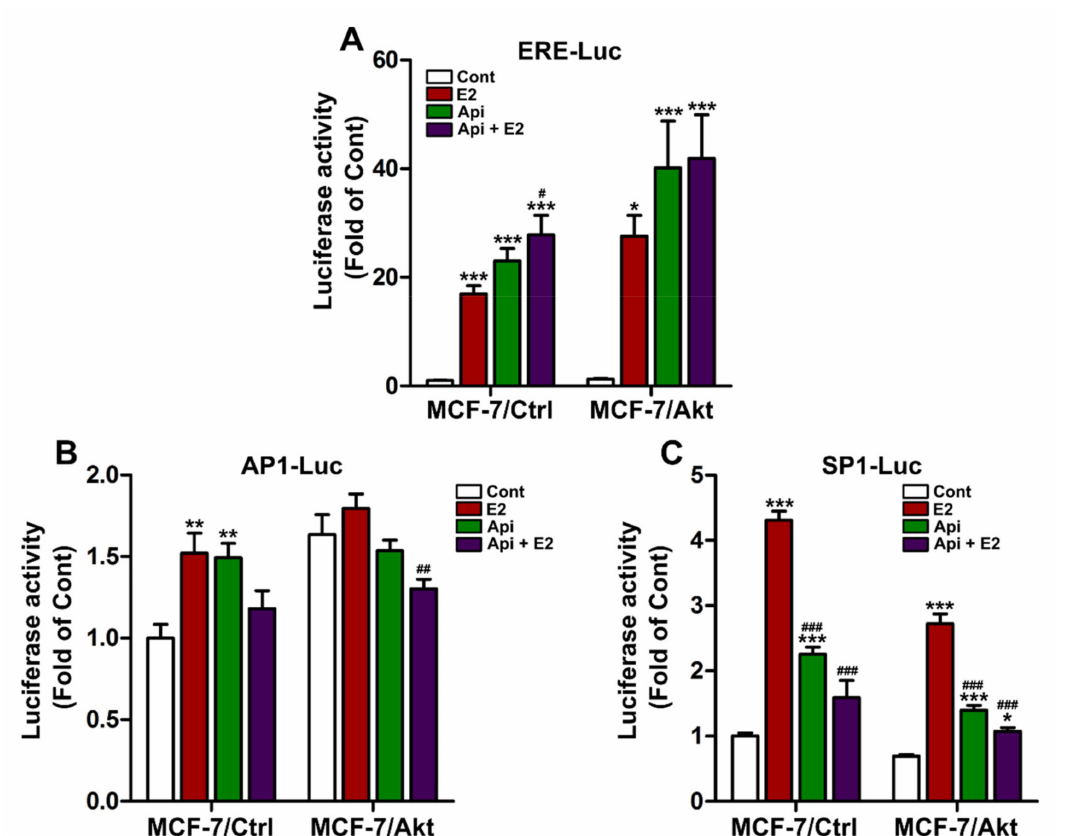
Figure 4. Effects of apigenin on the ER genomic activity. MCF-7/Ctrl cells and MCF-7/Akt cells were transiently transfected with an estrogen-responsive element luciferase reporter plasmid (ERE-Luc) ( A ), activator protein 1 luciferase reporter plasmid (AP1-Luc) ( B ) or specificity protein 1 luciferase reporter plasmid (SP1-Luc) ( C ) as well as a CMV- β -galactosidase plasmid as a control to assess transfection efficiency. Then, the cells were treated with 0.1% ( v / v ) DMSO and 0.1% ( v / v ) ethanol as the control (Cont), 1 nM estradiol (E2), or 10 µ M apigenin (Api) alone or in combination with E2 for 24 h. The experiment was conducted 3 times in triplicate. The results are expressed as the fold change in luciferase activity compared with that in the control of the MCF-7/Ctrl cells and are presented as the mean ± SEM. Statistical analyses were performed with one-way ANOVA followed by Tukey’s post hoc test. * p- value < 0.05, ** p -value < 0.01, *** p -value < 0.001 indicate significant differences from the control group in the same clone. # p -value < 0.05, ## p -value < 0.01, ### p -value < 0.001 indicate significant differences from the E2 group in the same